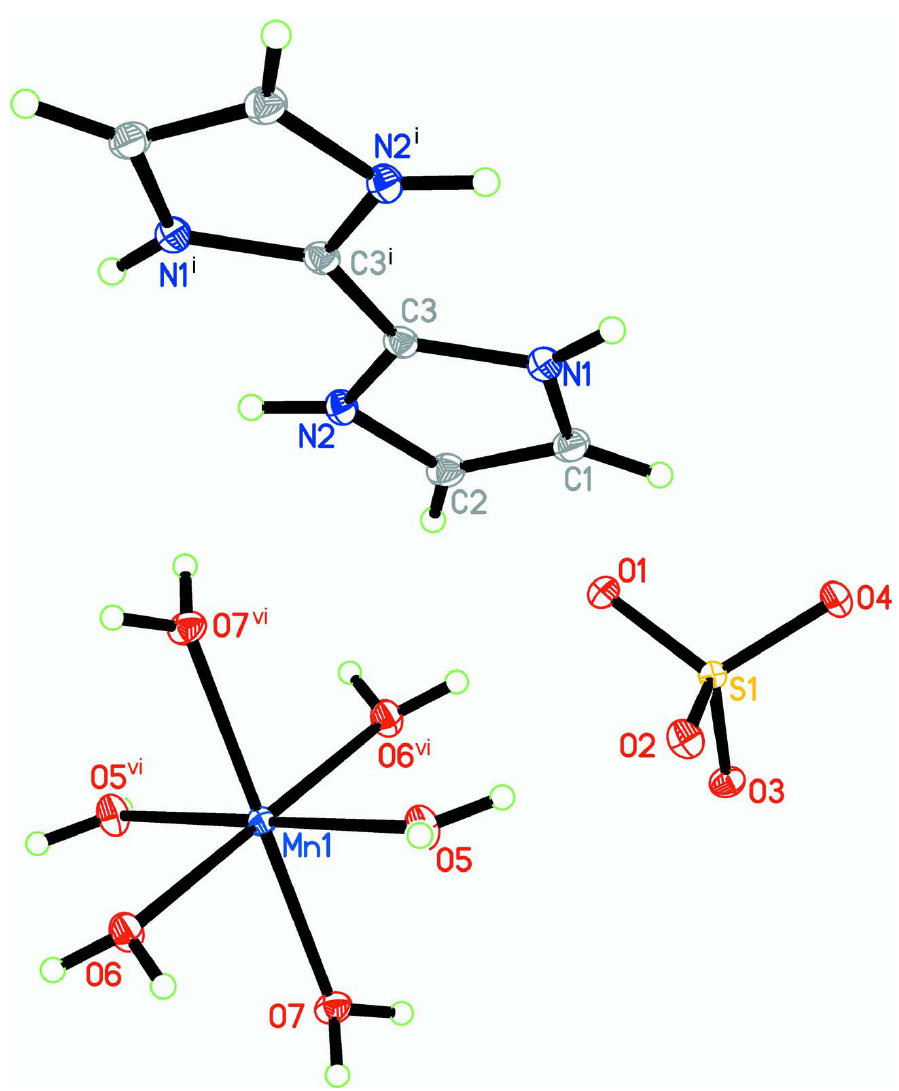
Figure 1 The molecular structure of the title compound. Displacement ellipsoids are drawn at the 50% probability level. [Symmetry codes: (i) -x, 2-y, -z; (vi) 1-x, 1-y,